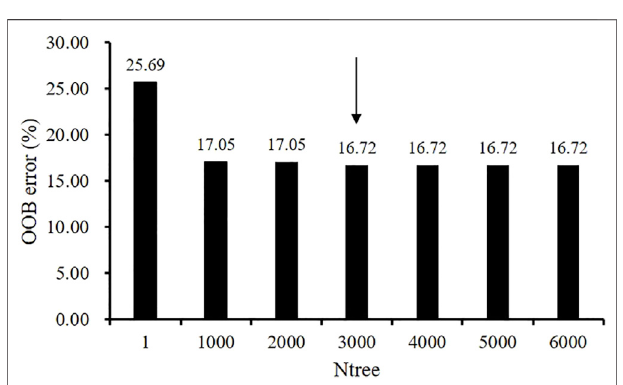
FIGURE 3 | The effect of the number of trees (Ntree) parameter on the performance of random forest RF using the OOB estimate of error (%).